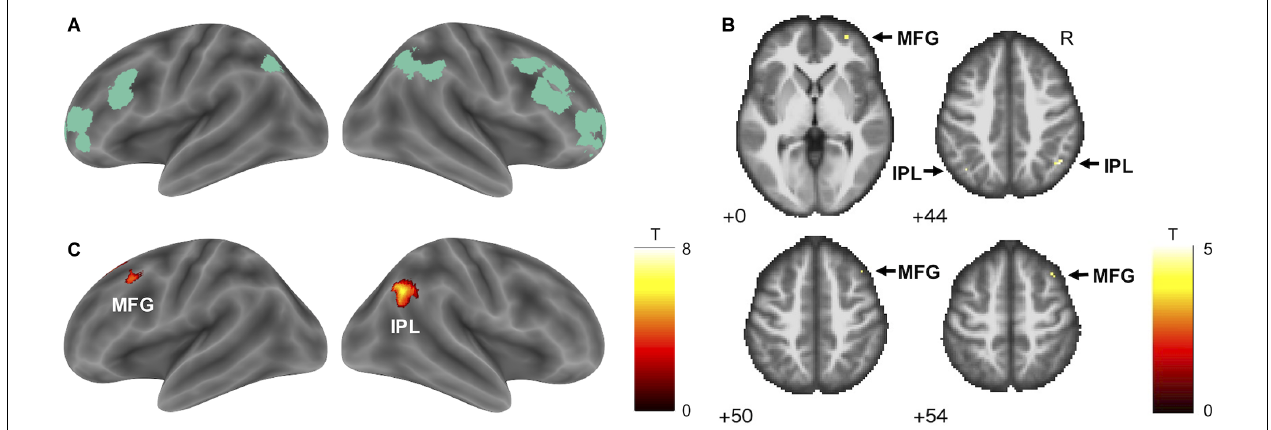
FIGURE 2 | Frontoparietal control network and its positive correlation with TTLC. (A) The frontoparietal control network ROI (green) based on Gordon et al. (2016). (B) The result of hypothesis-based ROI analysis. Within the ROI, activity in the bilateral IPL and right MFG was positively correlated with TTLC, an index of driving accuracy (SVC; voxel-level threshold p FWE < 0.05). Arrows indicate significant voxels. Numbers in each axial section indicate the z coordinates in MNI space. (C) Exploratory whole-brain analysis showed significant positive correlations between activity in the right IPL and left MFG with TTLC (cluster-defining threshold: p < 0.001 uncorrected; cluster-extent threshold: p FWE < 0.05). Abbreviations: ROI, region of interest; TTLC, the time to line crossing; IPL, inferior parietal lobule; MFG, middle frontal gyrus; SVC, small-volume correction; FWE, family-wise error; MNI, Montreal Neurological Institute.